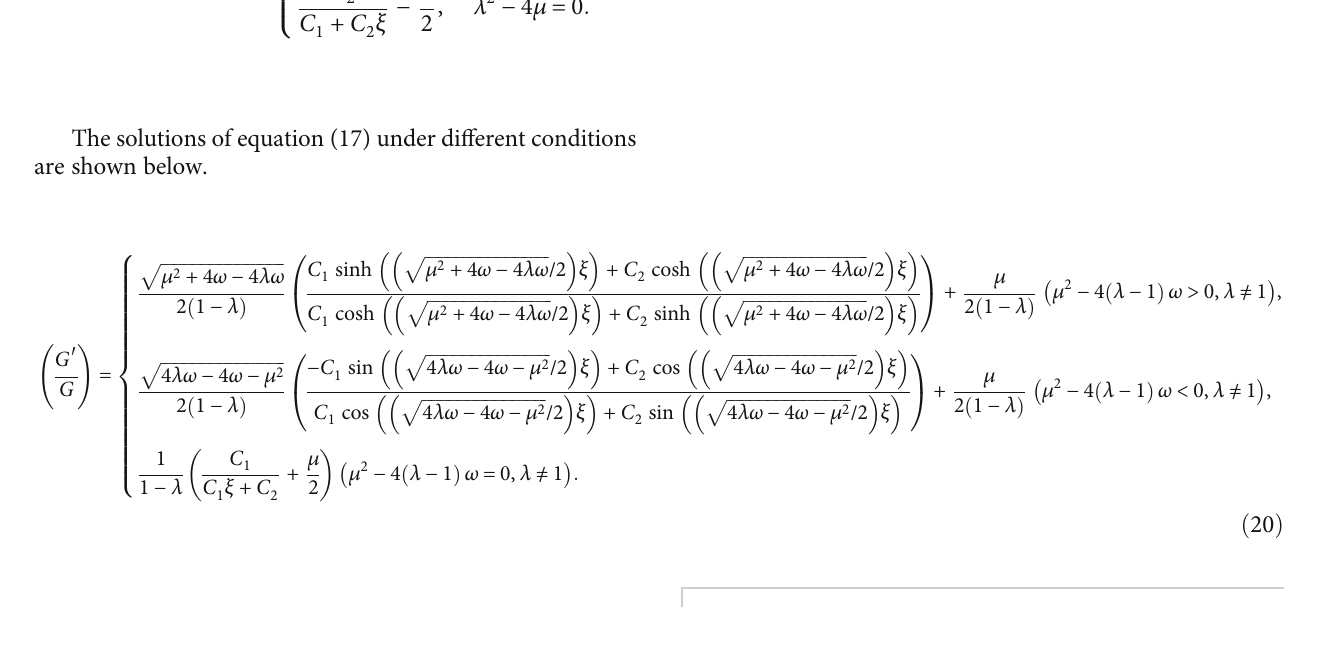
p λ 2 − 4 μ p λ 2 − 4 μ p 4 μ − λ 2